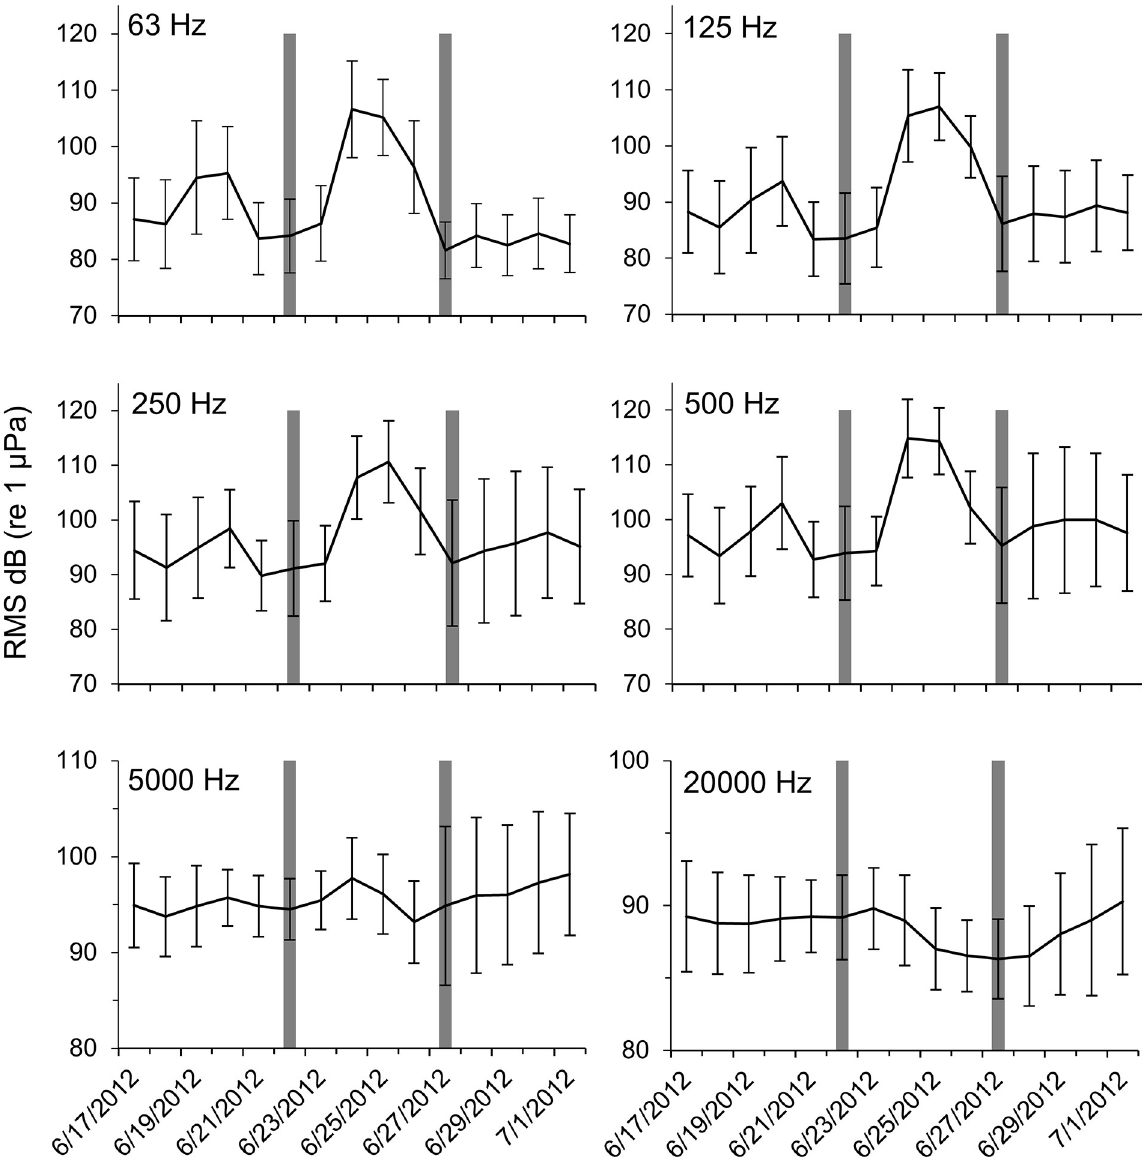
Fig 3. Boca 3 sound pressure levels during Tropical Storm Debby. Daily mean RMS sound pressure levels at station Boca 3 (inshore) for third-octave bands centered at 63 Hz, 125 Hz, 250 Hz, 500 Hz, 5000 Hz, and 20,000 Hz third-octave bands. Dark bars indicate the first day of the “during storm” period, and the first day of the “after storm” period. Error bars ± 1 SD. Note that the scale of the y-axes for the top four panels are not the same as the bottom two panels. their lowest values during the peak of the storm (June 24, Fig 7A). Total fish calls per 24-hour period then increased to their highest values after the storm (Fig 7A). Similar patterns were also observed for sand seatrout and silver perch (Fig 7A and 7B). Gulf toadfish and grunts also had a minimum in call detections during the peak of the storm; however, this decrease was not as dramatic and unusual as seen with other species or total fish calls (Fig 7A and 7B). The calls of spotted seatrout were only detected in low numbers for two days before the storm, while a single red drum call was detected after the storm (Fig 7C). Mean fish calls per acoustic file for total fish calls (all species) and sand seatrout decreased to their lowest value during the storm